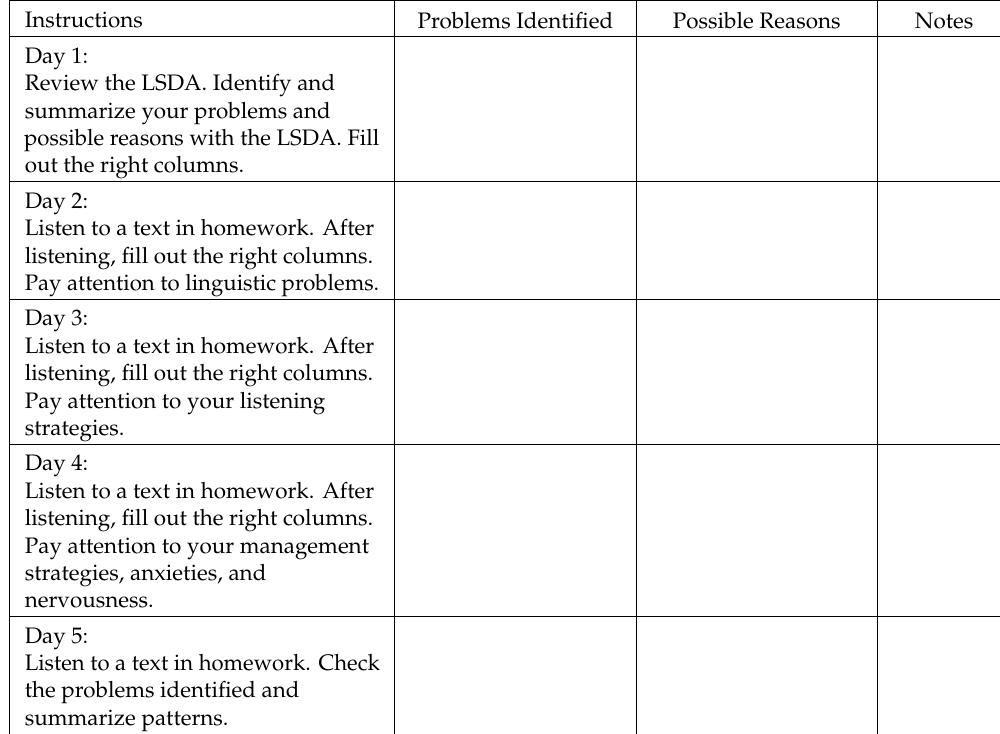
Table A1. A sample of application worksheets for the self-directed